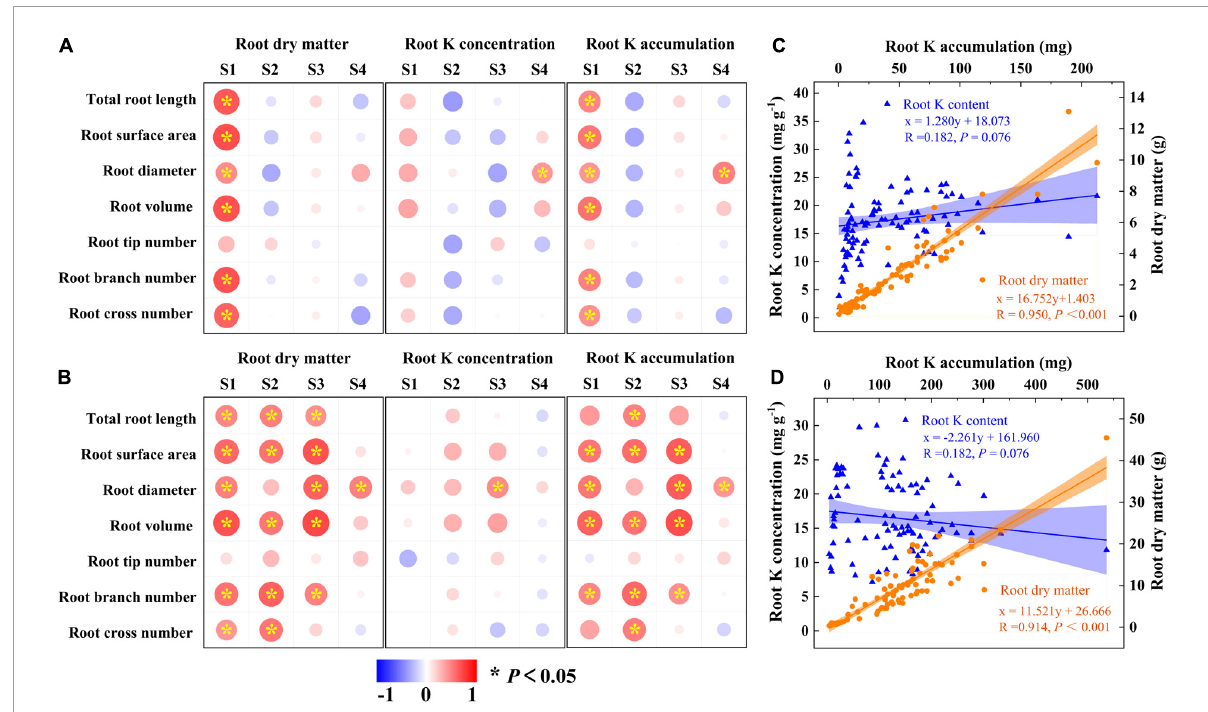
FIGURE8 Pearson’s correlation coefficients between root morphological index, root dry matter, root K concentration, and root K accumulation of N1 (A) and Xu28 (B) . Relationship between root K concentration or root dry matter and root K accumulation of N1 (C) and Xu28 (D) . Asterisks denote significant differences (* P < 0.05). The value of R and P given in each figure to exhibit the significant level ( P < 0.05, significant; P ≥ 0.05,